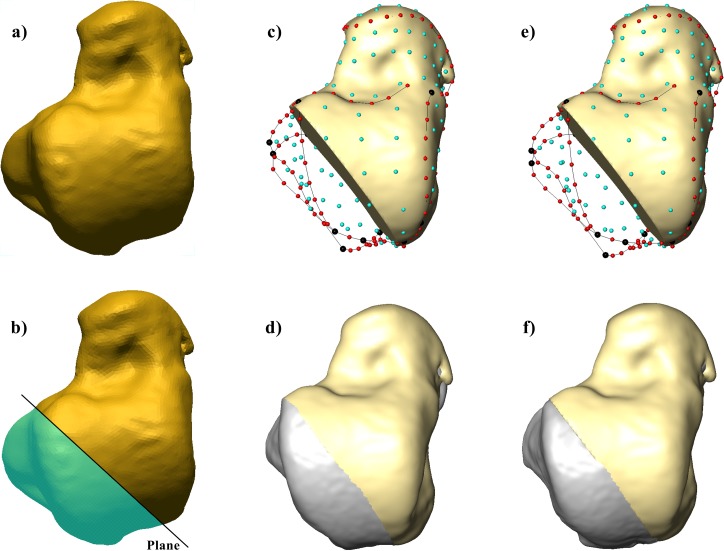
The left talus of BO-F-45 individual of Bologna (a) and the cutting plane used for the virtual resection (resected area in light blue) (b). Estimation of (semi)landmarks and reconstruction of the missing portion (in gray) based on the mean of both the Bologna sample (c, d) and the pooled sample (e, f).